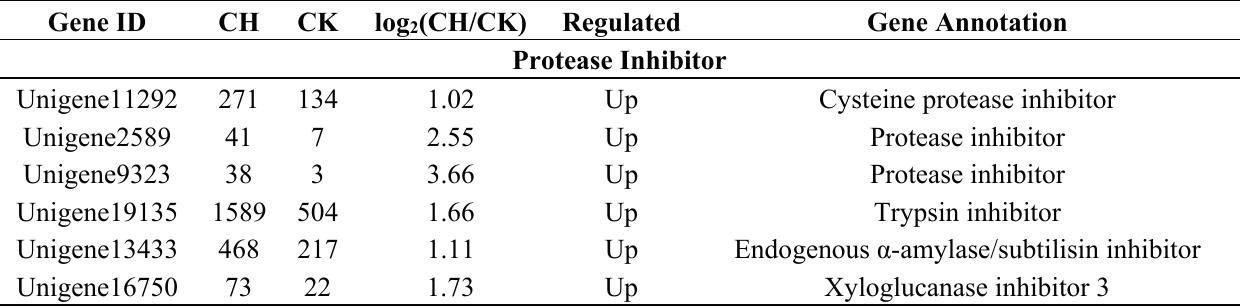
Table 3. Defense-related differentially expressed genes (DEGs) in P. coffeae -challenged ramie